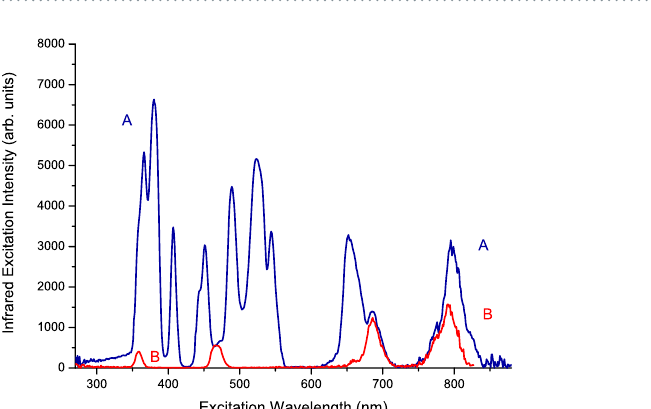
Figure 2. Schematic diagrams of the energy-level structures of Er 3 + and Tm 3 + ions and the quantum cutting process.